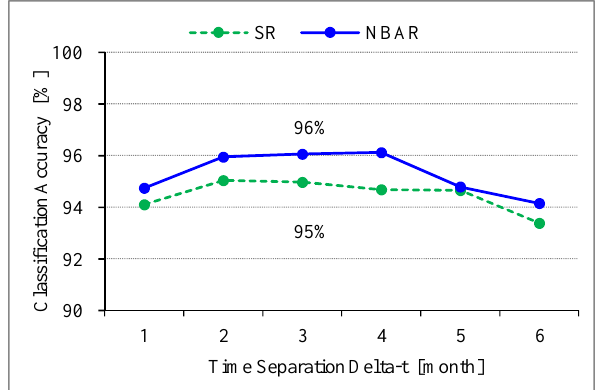
Figure 8. Classification accuracies obtained by time-domain co-occurrence matrix which is defined with reflectance.